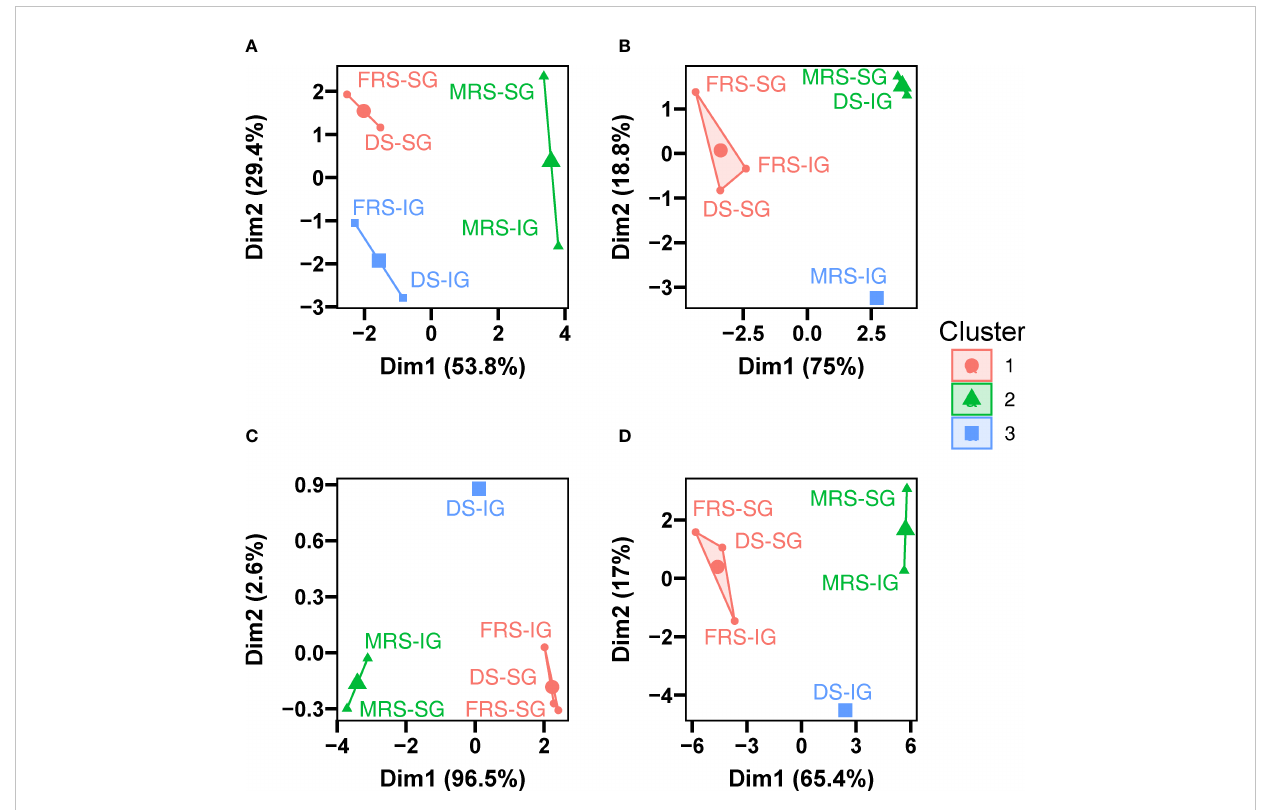
FIGURE 11 Two-dimensional biplot of seeds of different maturity stages and grain positions based on K-means clustering. (A) Morphological data, (B) multispectral data, (C) auto fl uorescence data, and (D) multi-source fusion data.